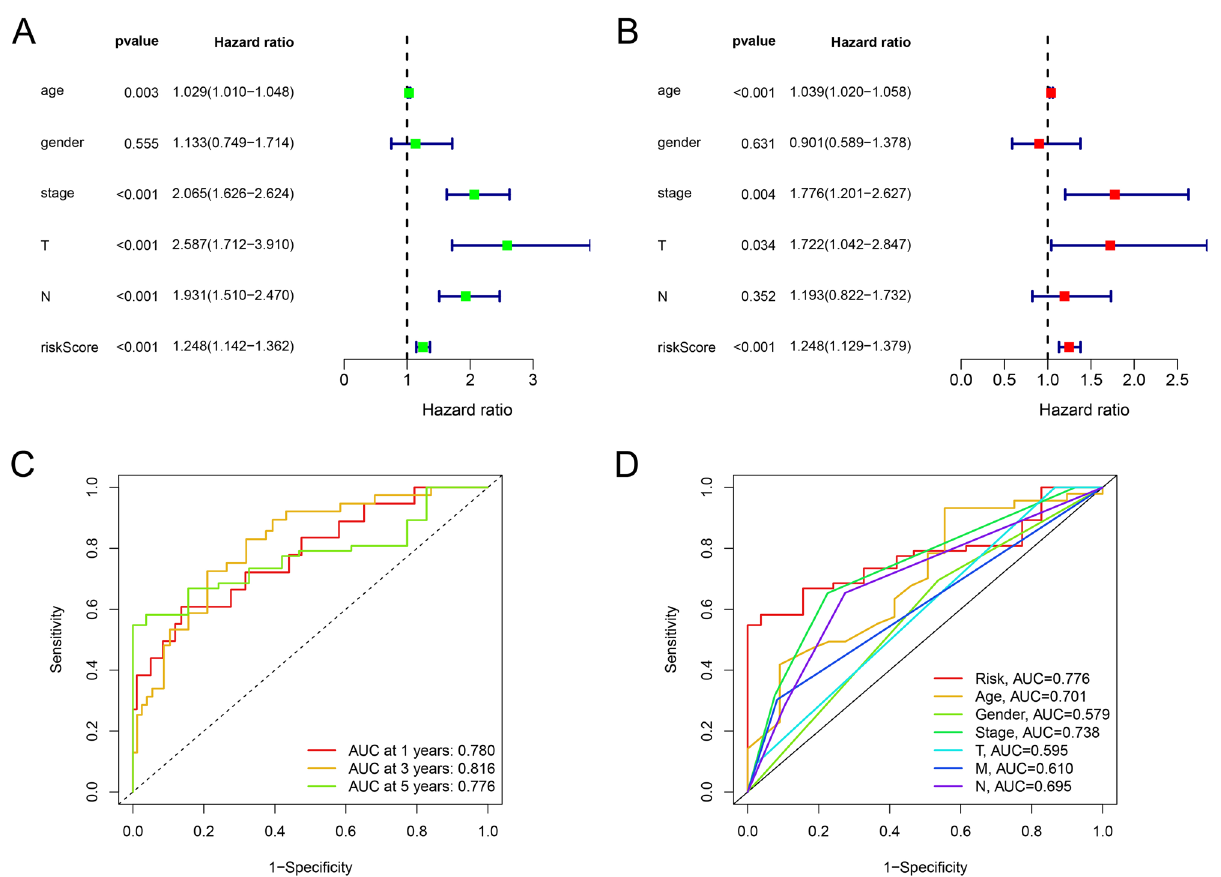
Figure 4. Validation of the prognostic model in GSE39582. ( A ) Univariate independent prognostic analysis in the GSE39582 cohort. ( B ) Multivariate independent prognostic analysis in the GSE39582 cohort. ( C ) AUC values at 1, 3 and 5 years in the GSE39582 cohort. ( D ) ROC curves of risk scores and clinical characteristics in the GSE39582